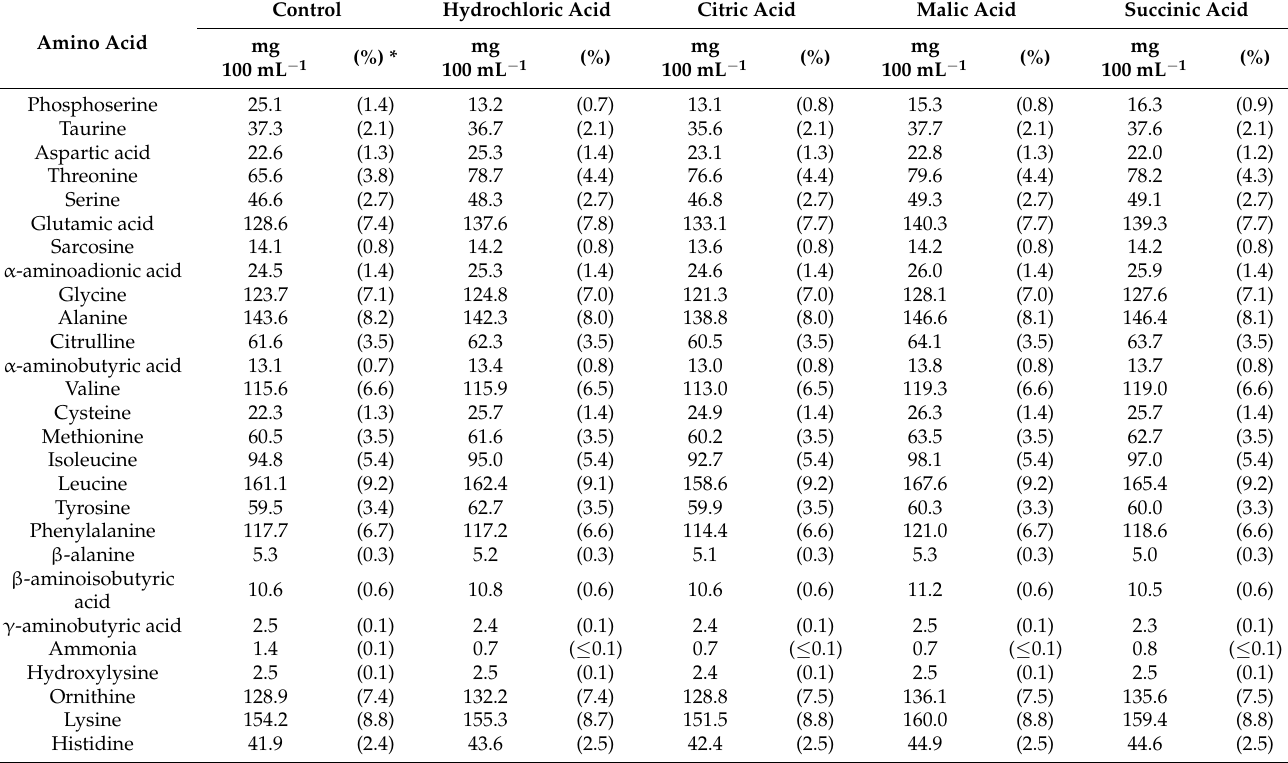
Table 2. Differences in the free amino acids of the enzymatic protein hydrolysates according to organic acid